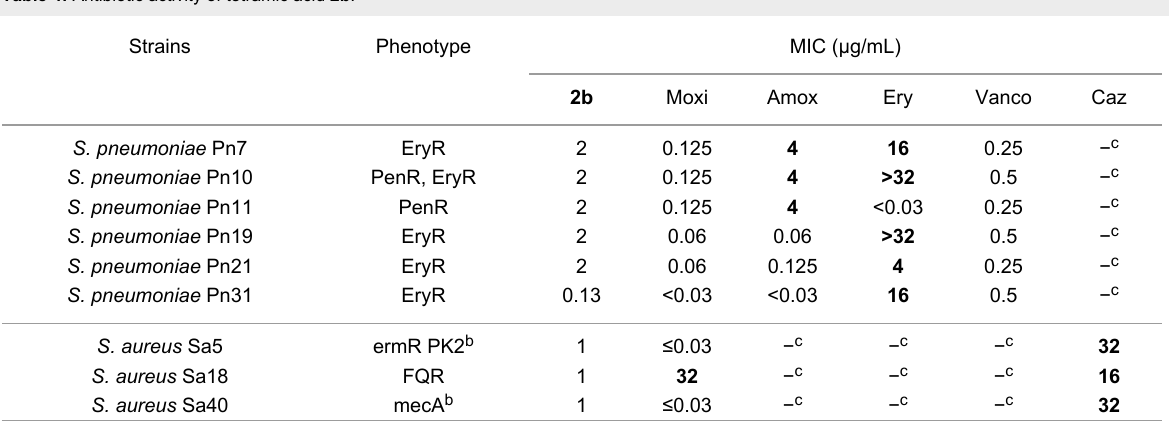
Table 4: Antibiotic activity of tetramic acid 2b .